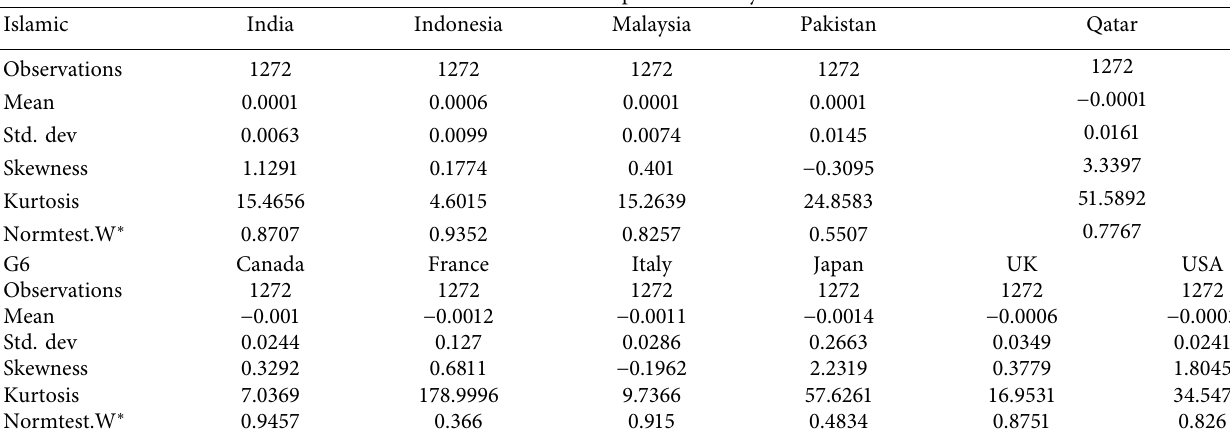
Figure 1: Time series plots of bond yield indices and returns for Islamic and G6 markets. Table 2: Descriptive